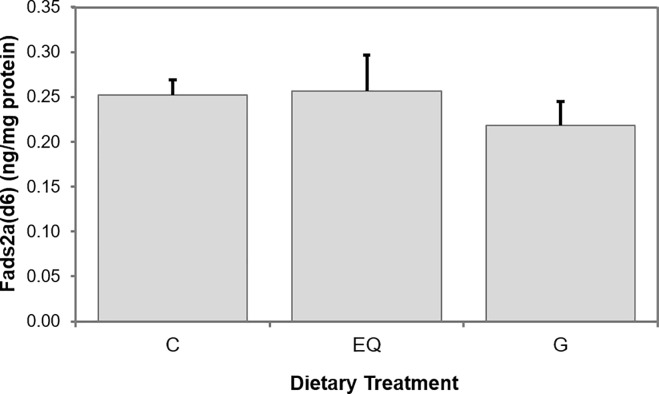
Fatty acyl desaturase 2a (delta-6) (Fads2a(d6)) protein levels in liver samples.Rainbow trout were fed the experimental diets C, EQ and G for 52 days. Fads2a(d6) protein levels were determined by ELISA and were normalized to the total protein level (ng/mg protein). Bars represent the final expression values. At the end of the experiment, four individuals per treatment in total were sampled randomly (n = 4). Values were tested on significance based on the statistical models described in Material and Methods. No significant differences were found.